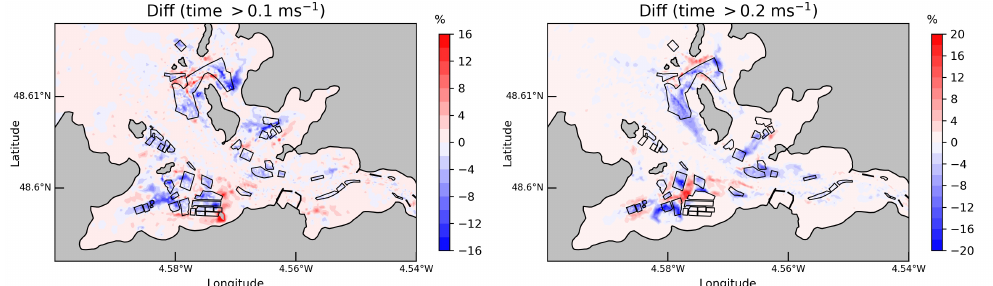
Figure 14. Differences in percentage of times for ¯ u > 0.1 ms − 1 and ¯ u > 0.2 ms − 1 during a mean spring tidal cycle between simulations E 2 and E 1